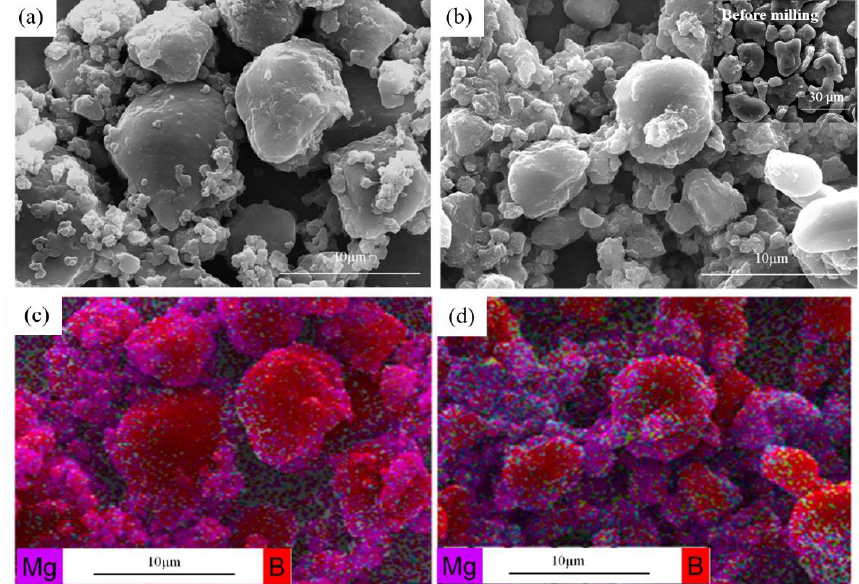
Figure 3. FESEM images of Mg/B1 composite powders cryomilling for ( a ) 6 h, ( b ) 9 h, and corre- sponding EDS images ( c , d ).